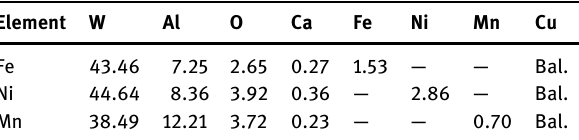
Table 1: Composition of microalloyed WCu composites Element W